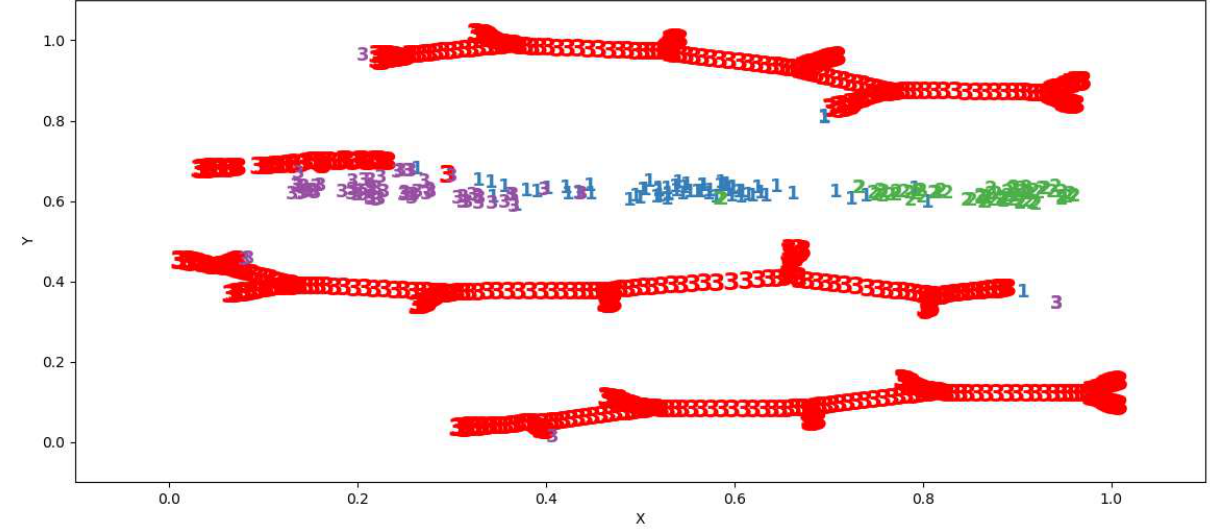
Figure 12. Successful adversarial attacks on the DNN classifier (highlighted in red).